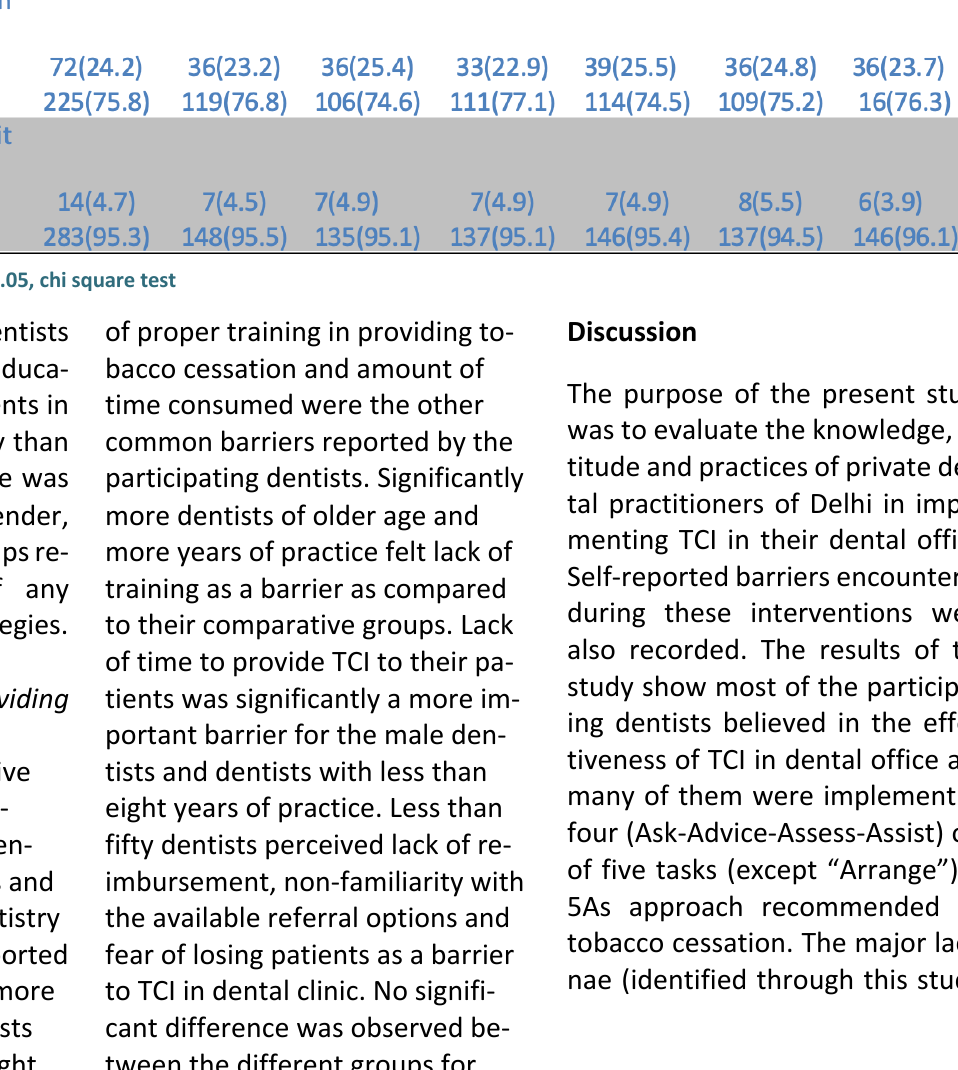
*sta-s-cally significant difference p<0.05, chi square